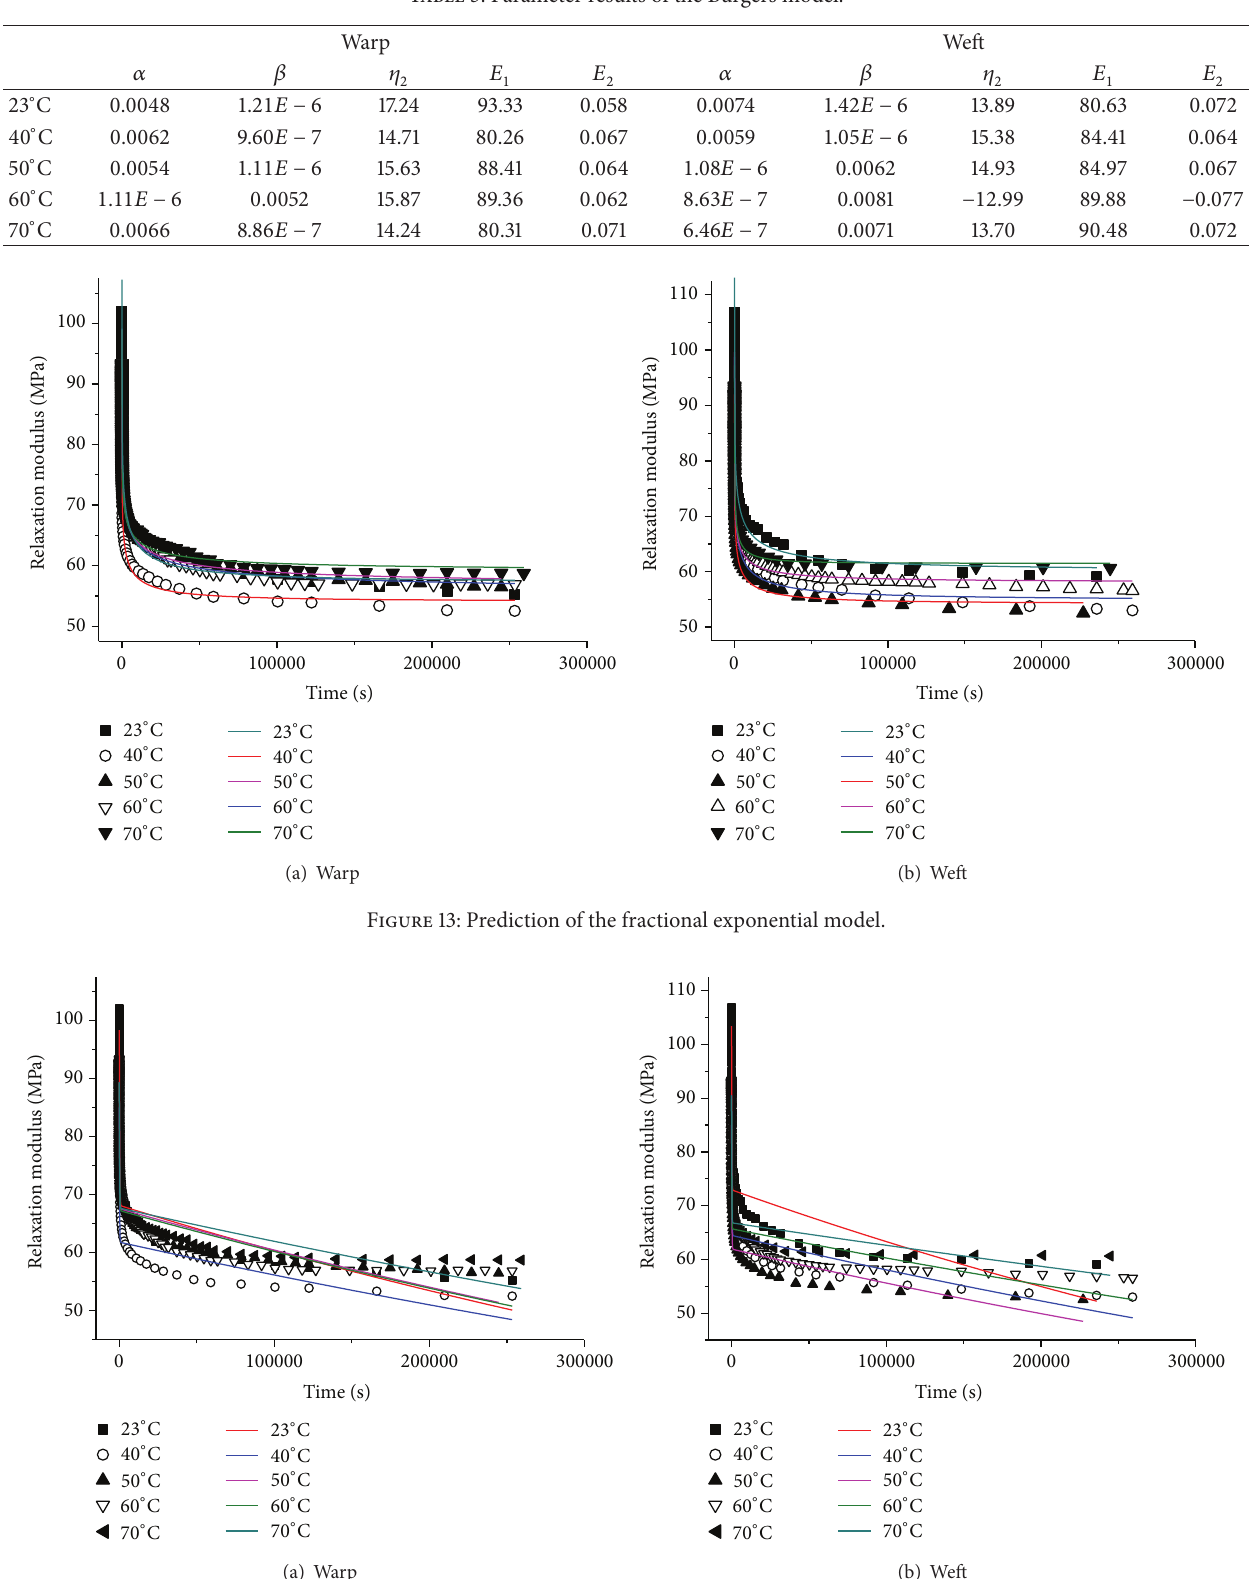
Figure 14: Prediction of the Burgers